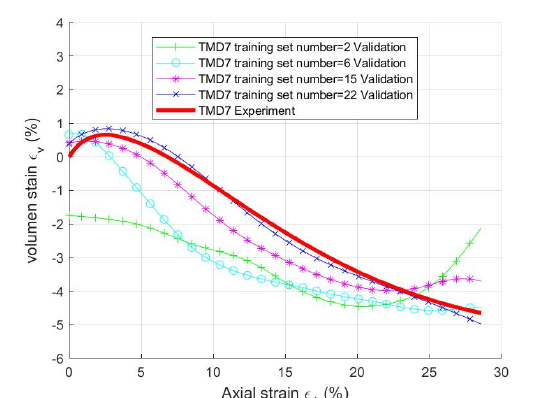
Fig. 3 Volumetric strain ε v versus axial strain ε 1 in drained monotonic triaxial tests ( I D0 = 0.51 and p 0 = 100 kPa).